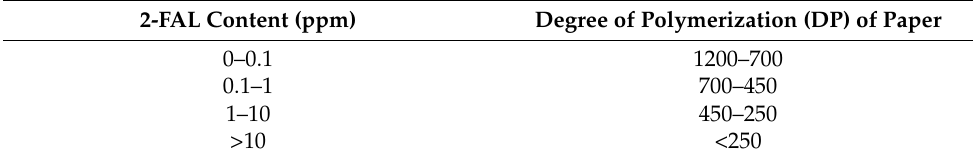
Table 10. Transformer condition according to the 2-FAL content.